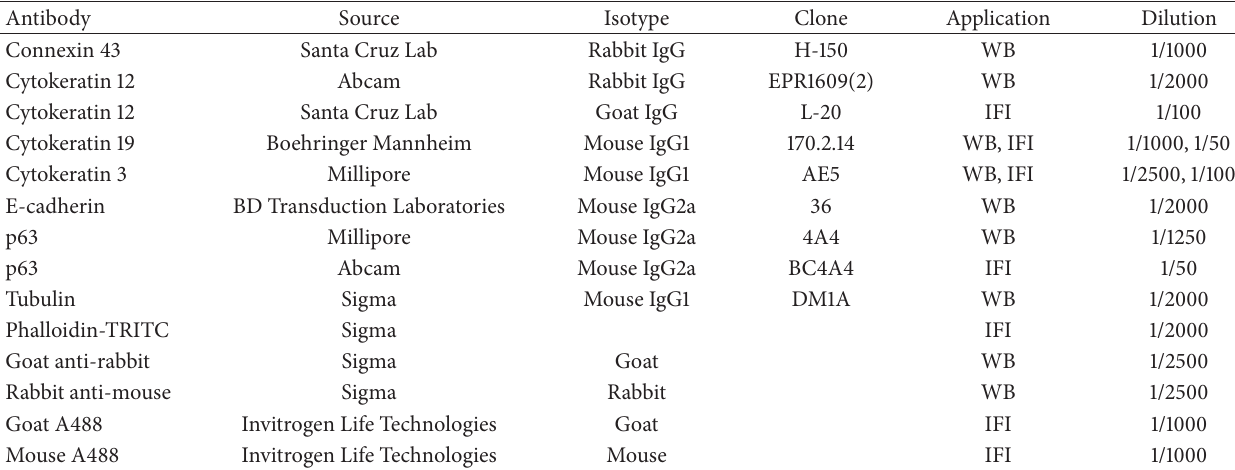
Table 1: Primary and secondary